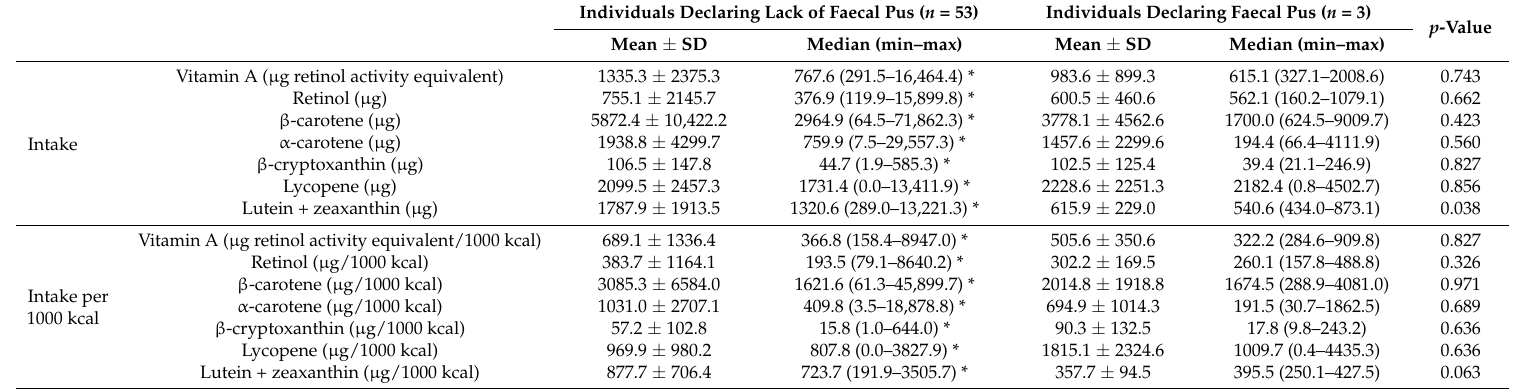
Table 4. The levels of retinoid intake in groups of individuals with ulcerative colitis declaring either a lack or presence of faecal pus (comparison conducted using U Mann-Whitney